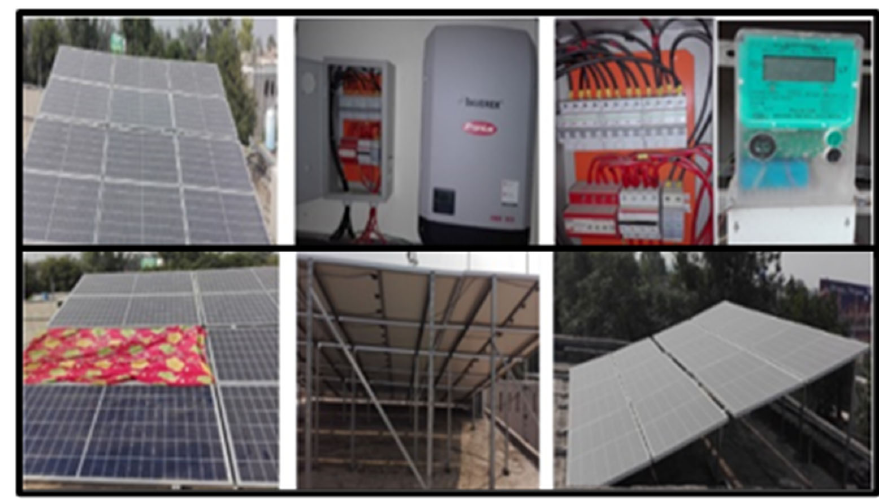
Figure 1. Process flow of the experimental setup.